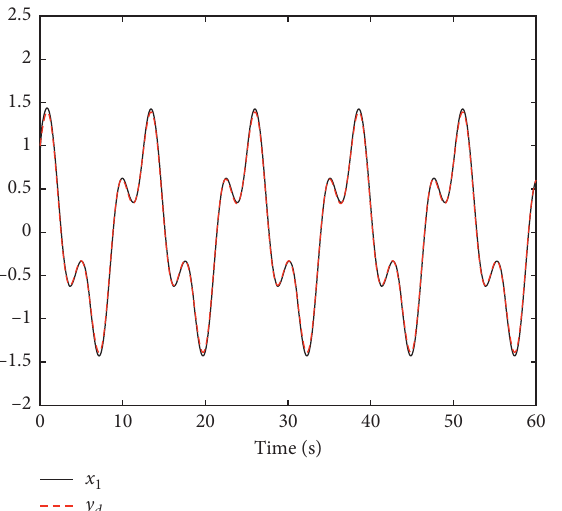
Figure 3: Actual control u .